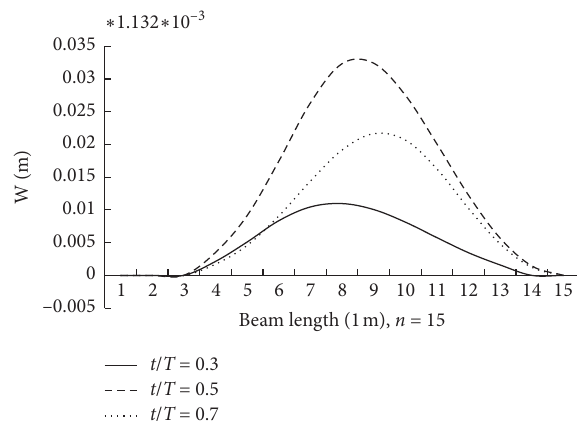
Figure 9: C-S T Beam (2) deflection, F � 30N.